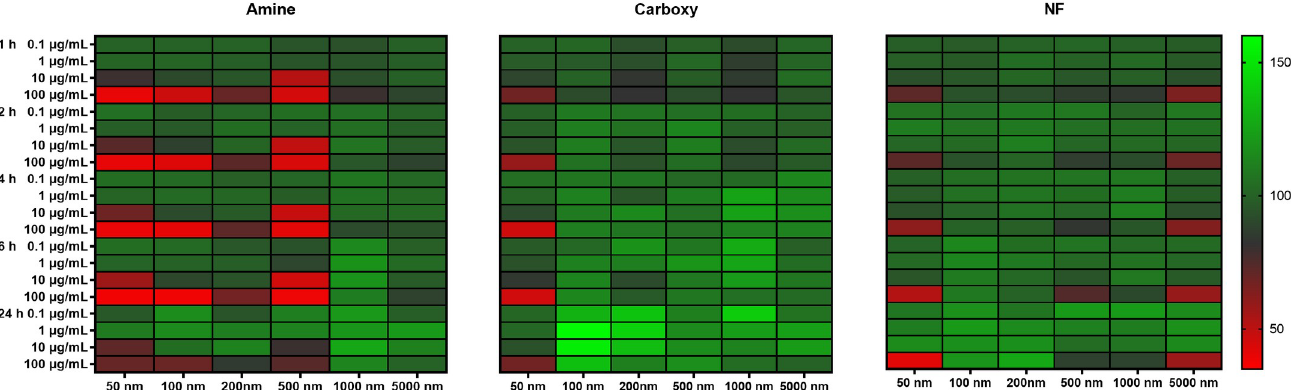
Fig 3. Percentage viability of cells after treatment with polystyrene particles. Heat map representing cytotoxicity of 50–5000 nm aminated, carboxylated or non- functionalized particles after 1, 2, 4, 6 and 24 h exposure of SNU-1 cells to doses of 0.1, 1, 10 and 100 μ g/mL. Data are represented as percentage viability, normalized to blank (untreated cells) responses; data range shown is between 35 to 160% (n = 3). Green represents high viability, while red represents low viability.